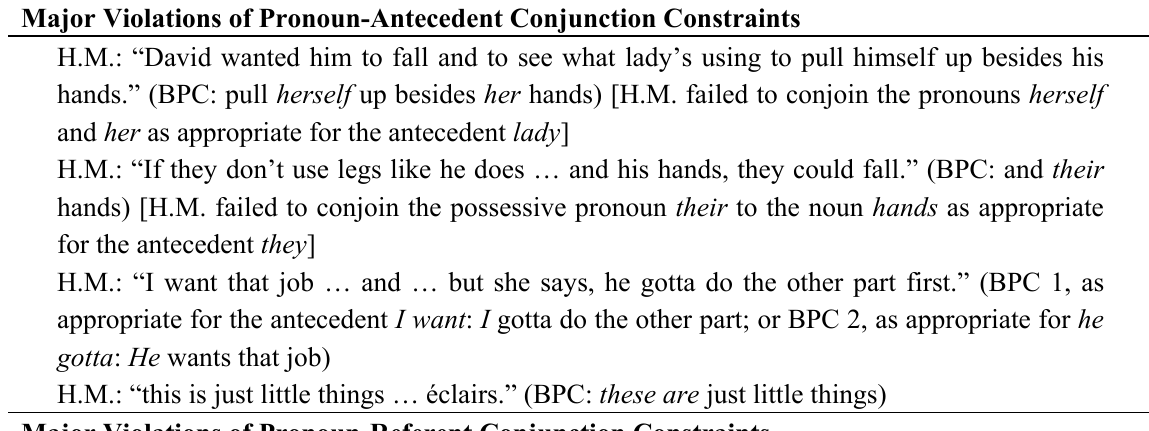
Table 5. Major commission-type violations of CCs in Study 2 organized by type of